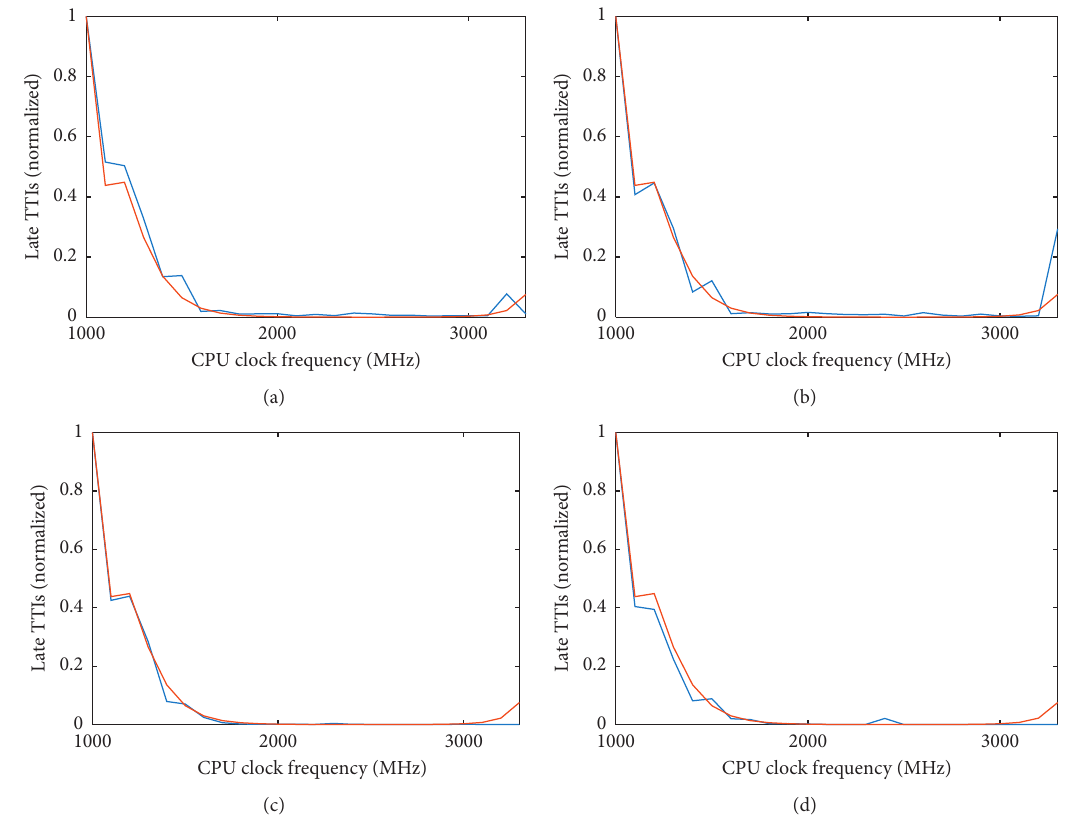
Figure 11: System 2: comparison of actual and predicted lates for f bandwidth. (c) 15 MHz bandwidth. (d) 20MHz